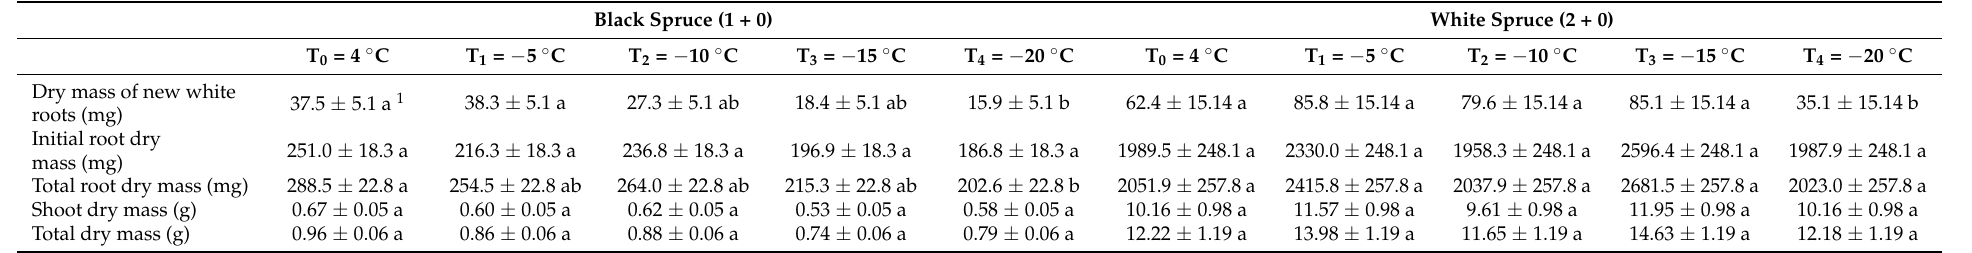
Table 3. Comparison of the adjusted means ( ± standard error) of different growth variables of white spruce (2 + 0) and black spruce (1 + 0) seedlings at the end of the fall in response to different freezing temperatures and after 21 days of growth during the recovery period under optimal greenhouse growing conditions. Black Spruce (1 +